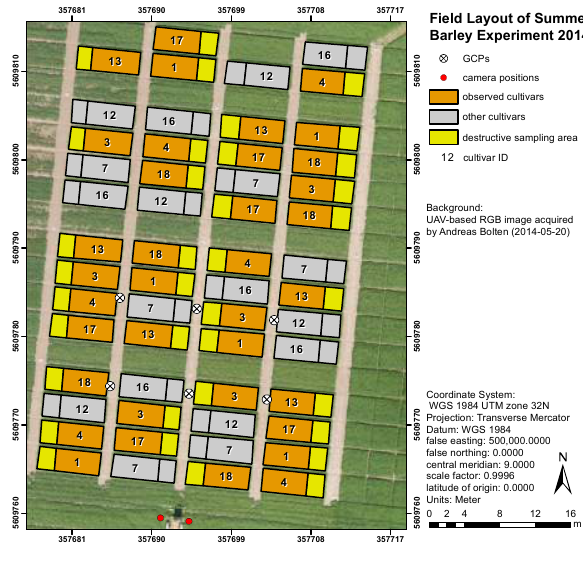
Figure 1. Study site